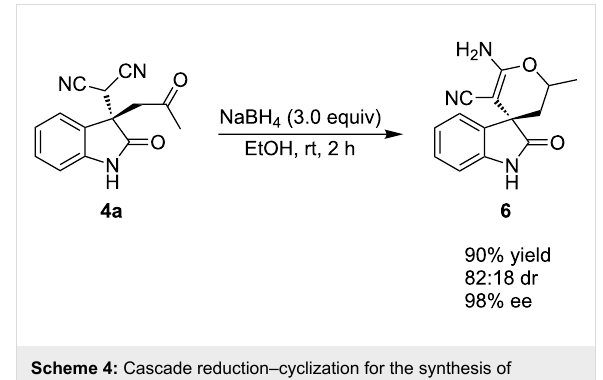
Scheme 4: Cascade reduction–cyclization for the synthesis of